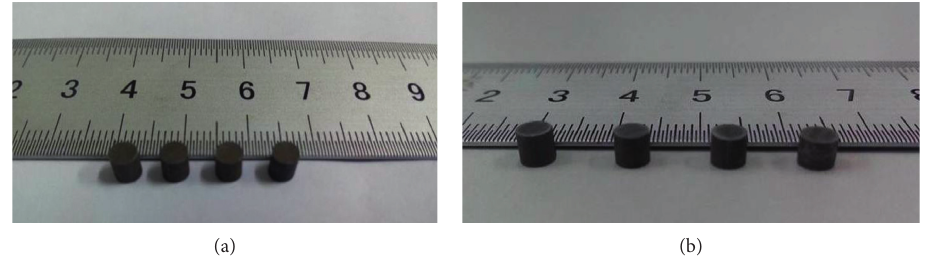
Figure 8: Hopkinson test samples. (a) Before test. (b) After test.